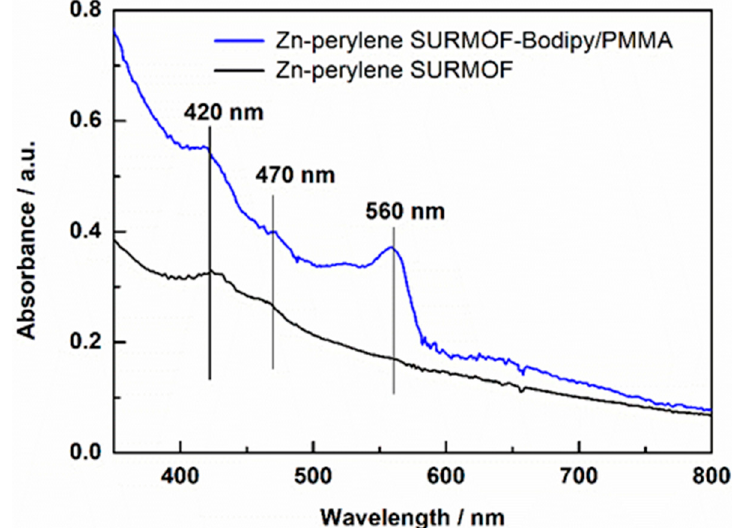
Figure 3. UV–vis spectra of Zn-perylene SURMOF-Bodipy/PMMA (in blue) and Zn-perylene SURMOF (in black).